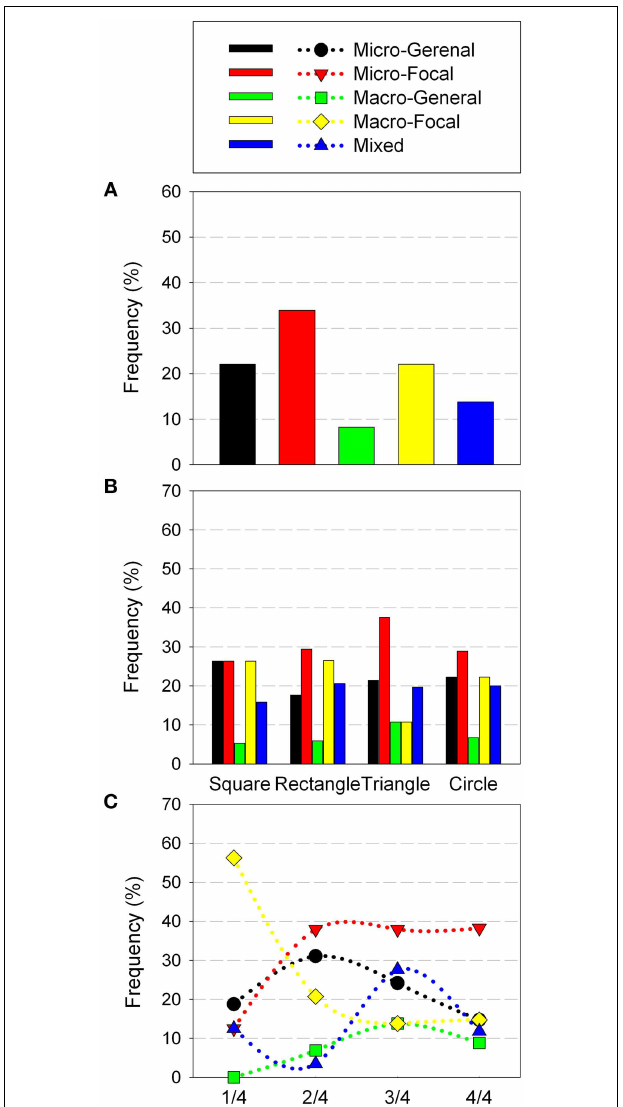
FIGURE 4 | Sensorimotor Strategies distribution in Experiment 1 according: general use (A) geometric shape (B) and trial order (C). The figures report the cumulative percent of strategies of all